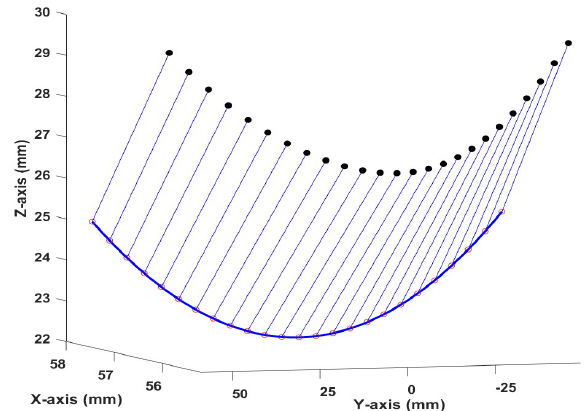
Figure 6. Tool−tip point trajectory and axis vector. Figure 6. Tool-tip point trajectory and axis vector.